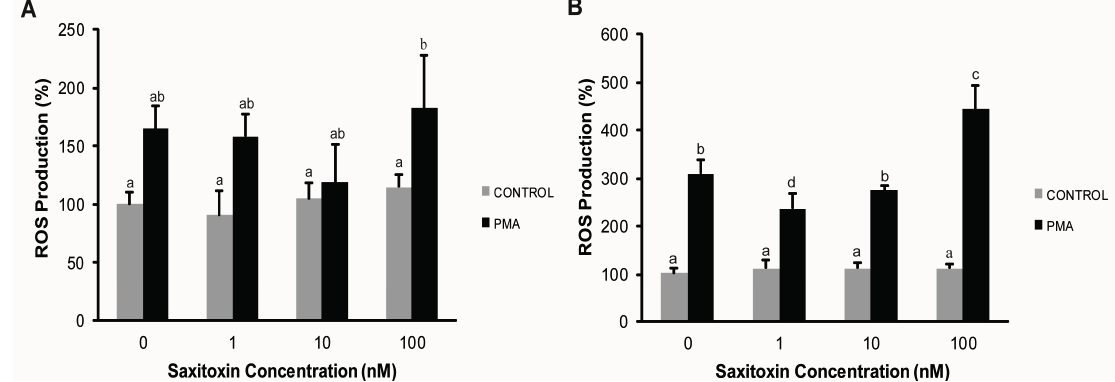
Figure 3. Evaluation of STX effects on reactive oxygen species (ROS) production in hemocytes. Cells were incubated with STX for ( A ) 4 h or ( B ) 16 h and later incubated with 10 µM dichlorofluorescein diacetate (DCFH-DA) for 90 min. PMA: Cells stimulated with 10 µg·mL − 1 PMA. Bars represent the mean ± standard errors ( n = 3 cultures of hemocytes). Different superscripts indicate statistically significant differences ( p < 0.05)